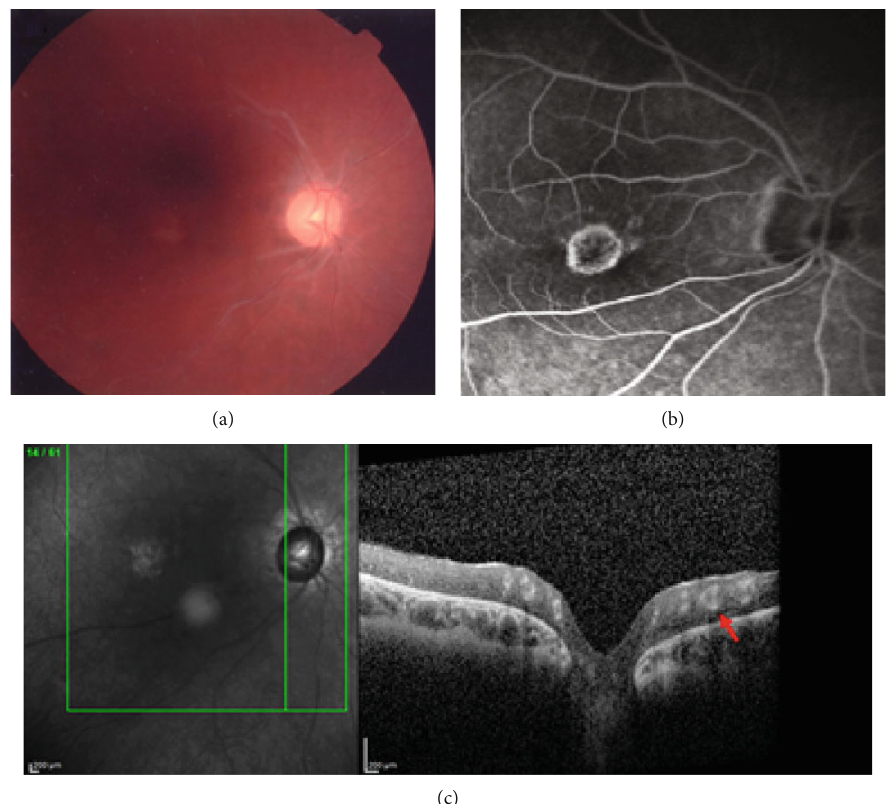
Figure 1: Case 1. (a) Fundus photography con fi rmed visible sheathed vessels. (b) FA; posterior pole showed a normal appearance of vessel walls and fl ow; no sheathing or leakage of dye was observed at any time. Window e ff ect appears in the foveal area due to atrophy of retinal pigment epithelium subsequent to chronic macular edema. (c) SD-OCT line scan showed very re fl ective vessel wall. The hyperre fl ection involves the entire vessel walls, and there is no di ff erence in re fl ectivity between veins and arteries. Vessel lumen appears patent, and the internal hourglass con fi guration is blurred, but identi fi